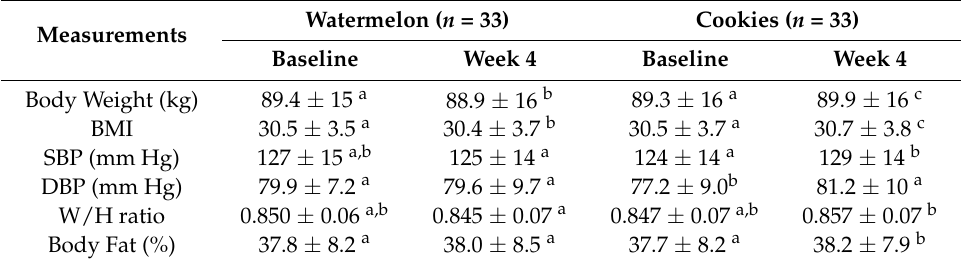
Table 1. Effects of snacks on body weight, body mass index (BMI), blood pressure, waist-to-hip ratio, and body fat of participants at baseline and week 4 for each